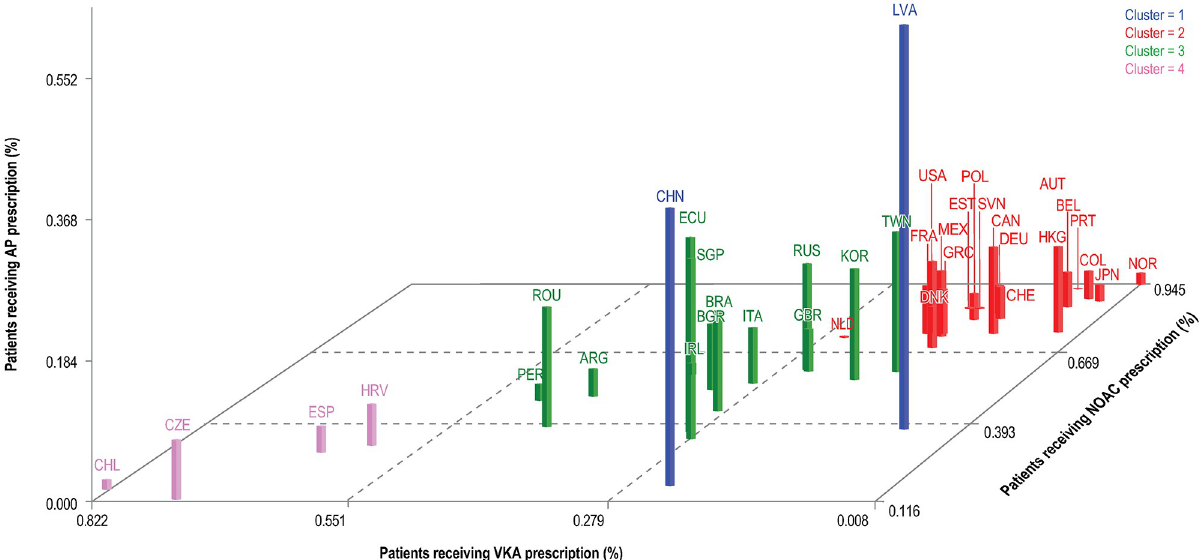
Fig 4. Analysis of ATT pattern in phase III by countries. AP, antiplatelet; ARG, Argentina; ATT, antithrombotic treatment; AUT, Austria; BEL, Belgium; BGR, Bulgaria; BRA, Brazil; CAN, Canada; CHE, Switzerland; CHL, Chile; CHN, China; COL, Colombia; CZE, Czech Republic; DNK, Denmark; DEU, Germany; ECU, Ecuador; ESP, Spain; EST, Estonia; FRA, France; GBR, United Kingdom of Great Britain and Northern Ireland; GRC, Greece; HKG, Hong Kong; HRV, Croatia; IRL, Ireland; ITA, Italy; JPN, Japan; KOR, Korea; LVA, Latvia; MEX, Mexico; NLD, the Netherlands; NOAC, novel/nonvitamin K oral anticoagulants; NOR, Norway; PER, Peru; POL, Poland; PRT, Portugal; ROU, Romania; RUS, Russian Federation; SGP, Singapore; SVN, Slovenia; TWN, Taiwan; USA, United States of America; VKA, vitamin K antagonist.